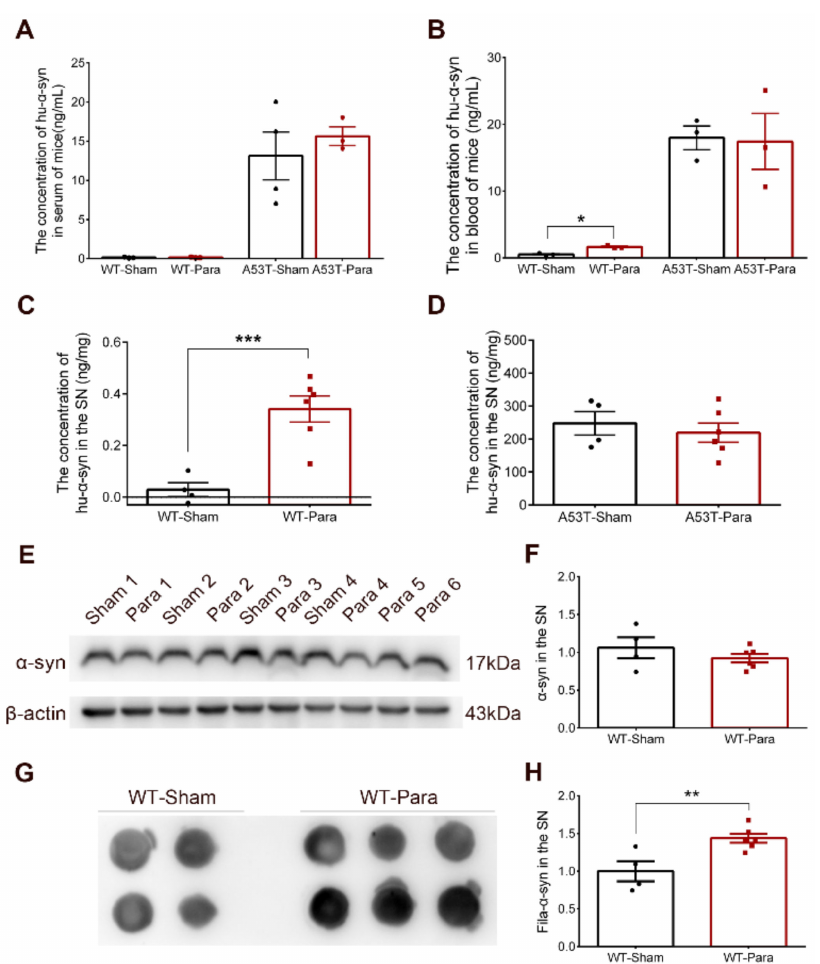
Figure 3. The pathological changes of α -synuclein in the SN of WT mice after parabiosis. ( A ) No Hu- α -syn was detected in the serum of parabiotic WT mice and no change was found in the